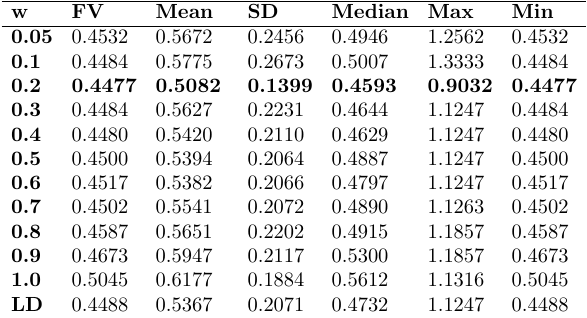
Table 1. Effect of inertia weight on